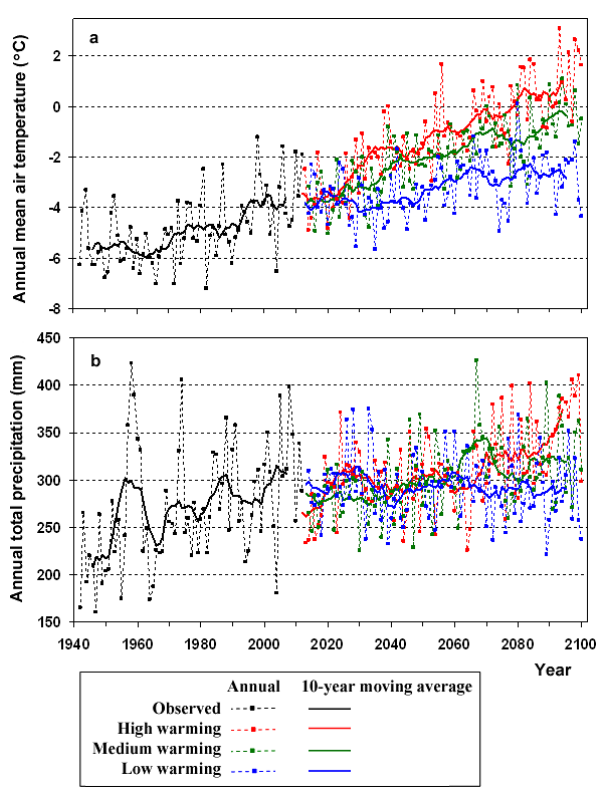
Figure 4. The historical climate trends and the selected three sce- narios for the 21st century for the (a) annual mean air tempera- ture and (b) annual total precipitation. The historical climate is ob- served at the Yellowknife airport climate station. The low, medium, and high warming scenarios were generated by CCCma (B1), CC- Cma (A1B), and MIROC (A1B), respectively. More details about the data and the climate models can be found at the World Data Center for Climate